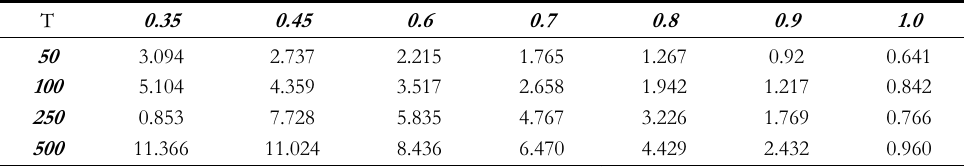
Autoregressive order selection: P